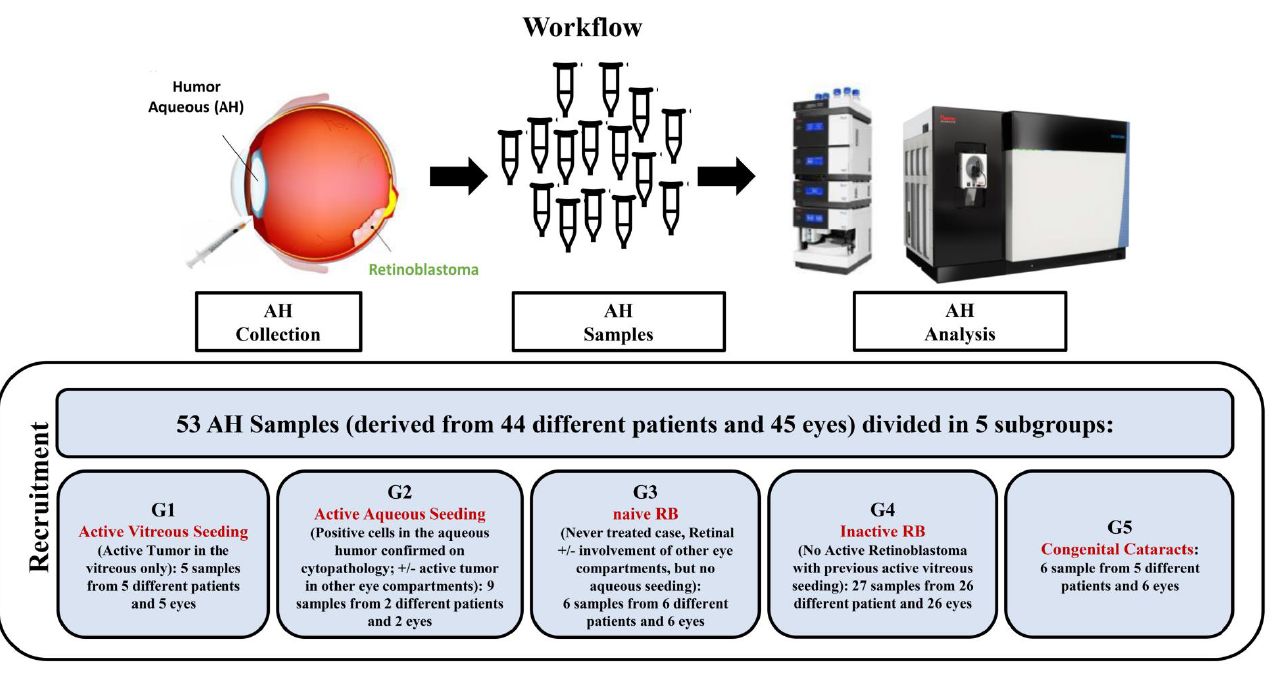
Figure 4. Workflow of the proteomic analysis of the aqueous humor in patients affected by retinoblas- toma. The figure was created with